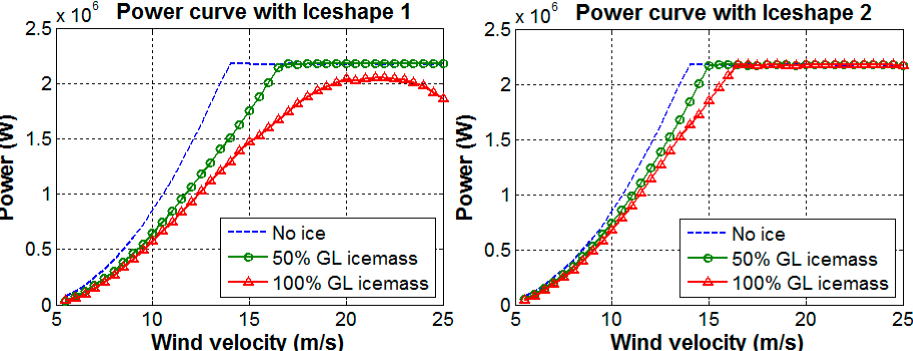
Figure 8. Power curves of the turbine with clean and iced blades.